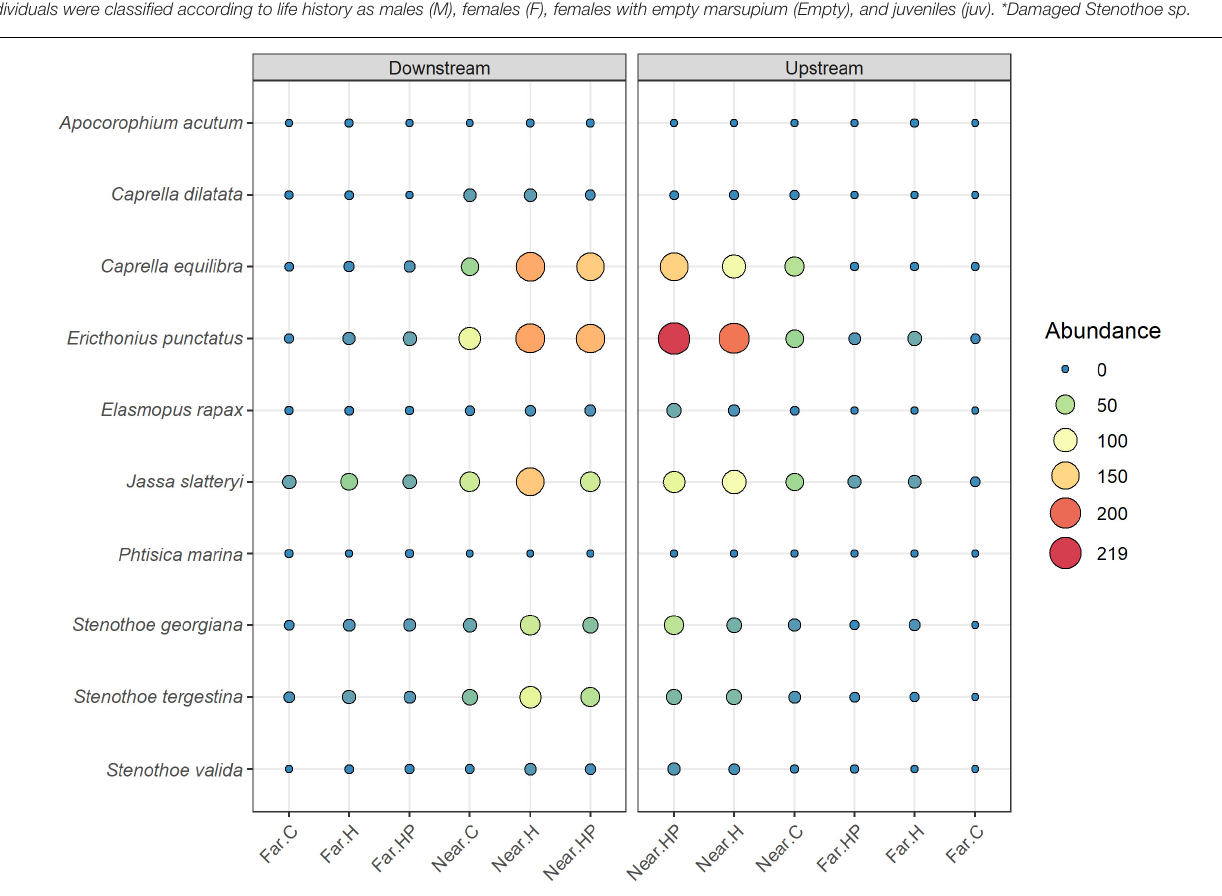
FIGURE 5 | Mean abundances of the main amphipod species studies in the different ACs containing habitat and feed pellets (HP), only habitat (H) or control (C) located near and far downstream and near and far